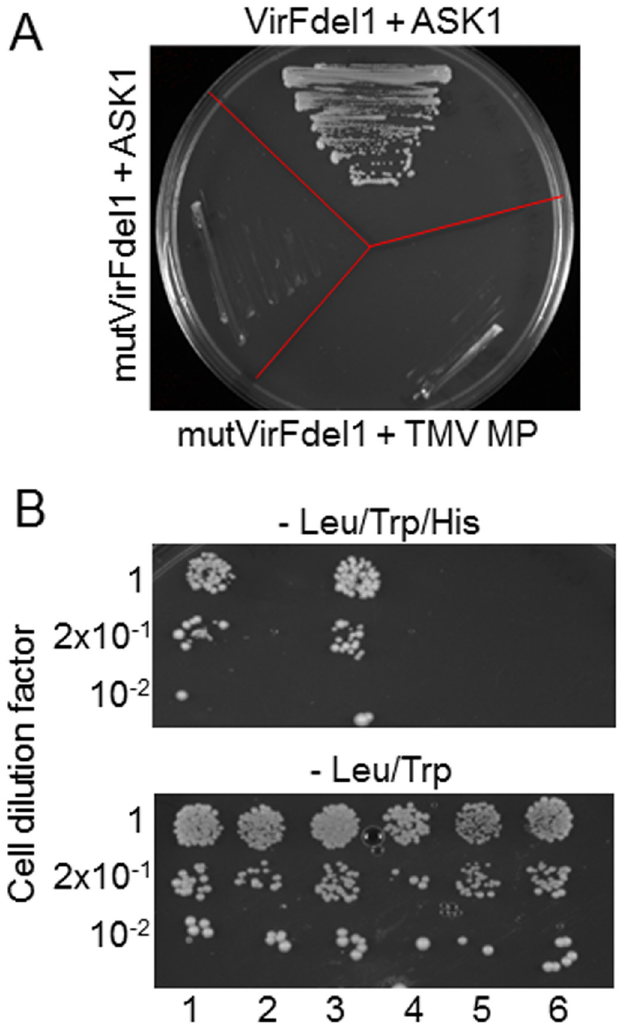
Fig 1. Specific interaction between VFP3 and VirFdel1 in the yeast two-hybrid system. (A) Characterization of the VirF-based bait, mutVirFdel1. Yeast cells were grown in the absence of leucine, tryptophan, and histidine. (B) VirFdel1-VFP3 interaction. The indicated dilutions of yeast cells were grown in the absence of histidine, tryptophan, and leucine (top) or in the absence of tryptophan and leucine